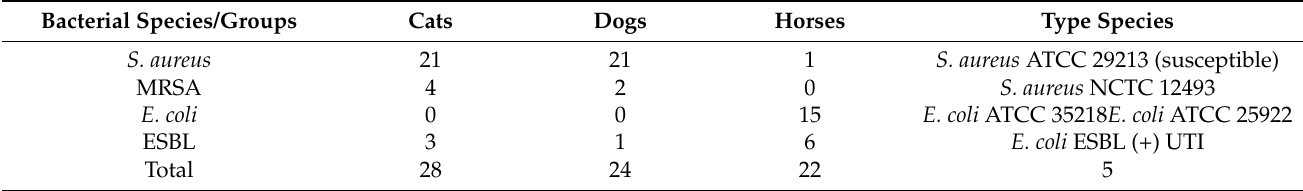
Table 1. Characteristics of bacterial strains used in the experiment.